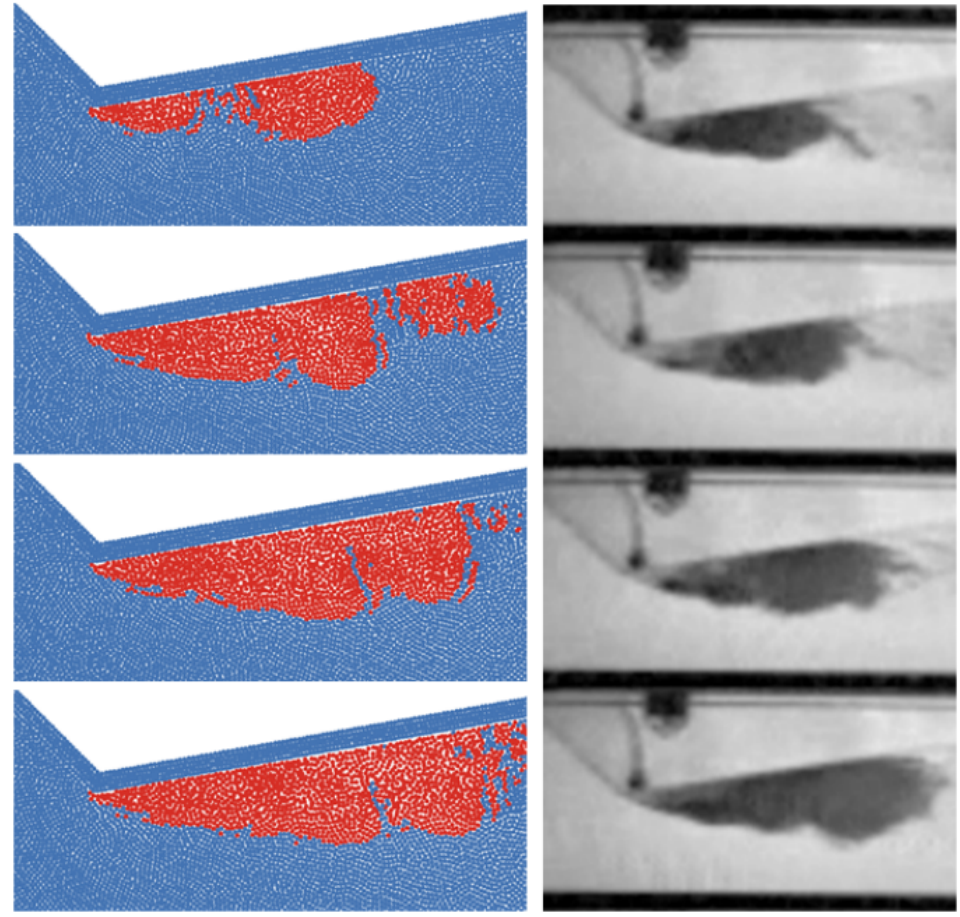
Figure 16. A comparison of the cavitation regions between SPH results (left) [73] and experimental snapshots (right)